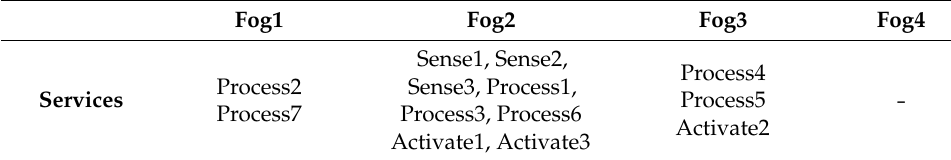
Process4 - Process5 Activate2